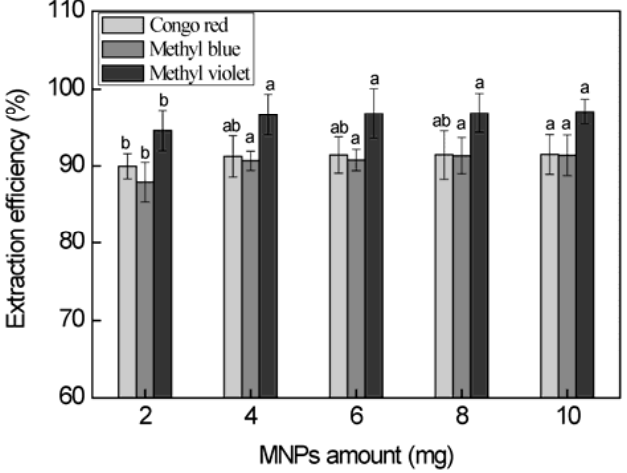
Figure 4. Effect of the Fe 3 O 4 @NH 2 amount added to the AMTPS on the extraction efficiency of dyes. (Each system contained 10 mL dyes solution (1 mg/mL CR, MB and 0.125 mg/mL MV), 4 wt. % TX-114, 40 min vibration time, and incubated at temperature 40 °C for 10 min). Different letters in the same series indicate significant difference at p < 0.05 level.